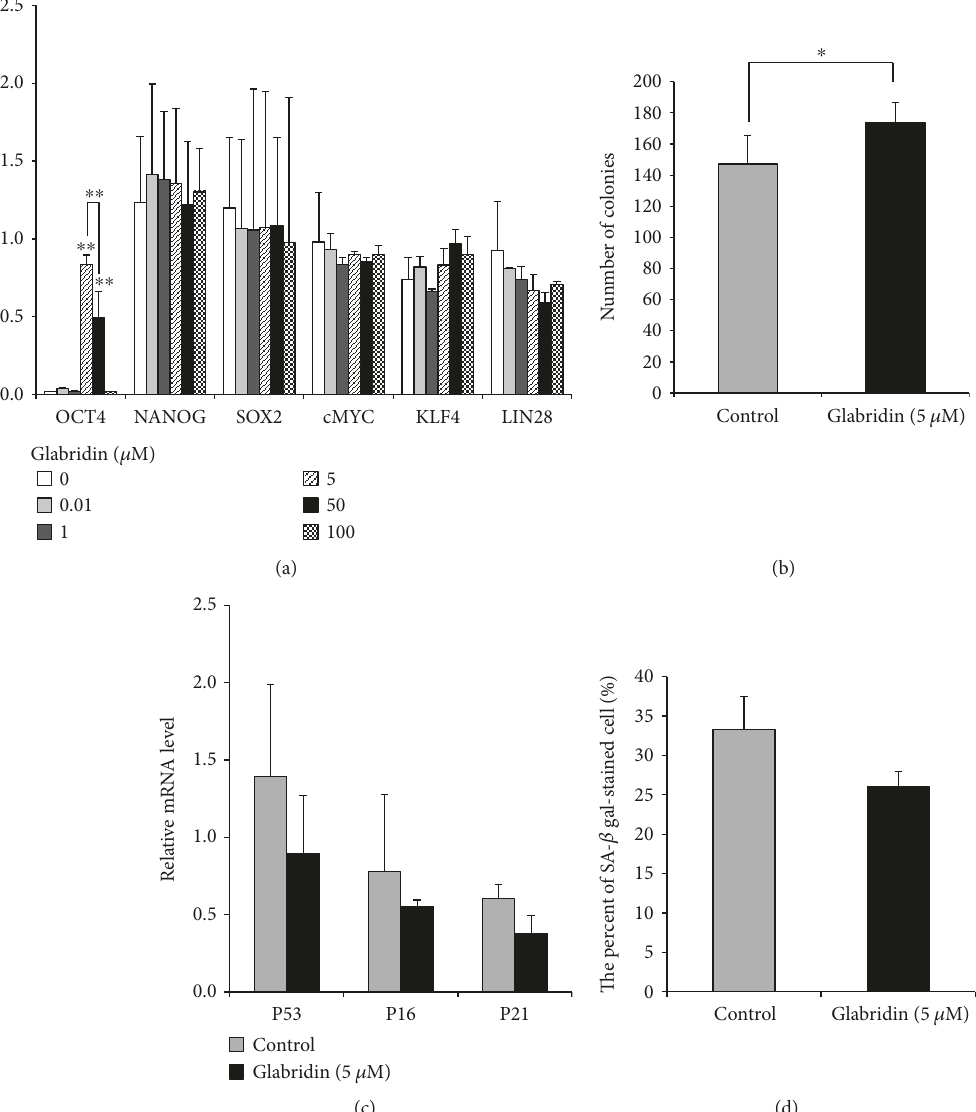
Figure 2: E ff ect of glabridin on stemness and senescence in MSCs. (a) Stemness marker expression in MSCs treated with an increasing concentration of glabridin. (b) Stemness was evaluated by a CFU-F assay. The number of colonies ( > 50 cells) was counted. (c) P53 , P16 , and P21 mRNA expression levels were analyzed using reverse transcription PCR (RT-PCR). (d) Senescence-associated (SA) β -gal assay. The number of β -gal-positive cells was counted. The data are expressed as the mean ± SD of three experiments. ∗ P < 0 05 and ∗∗ P < 0 01 versus untreated